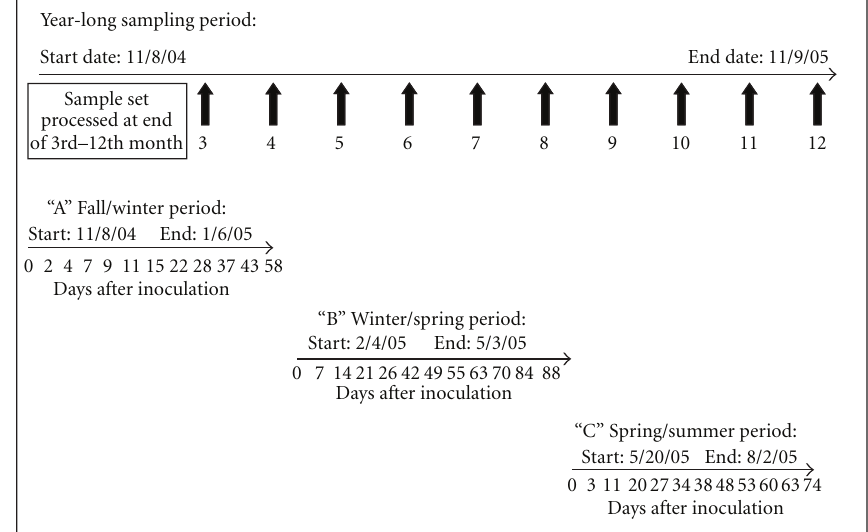
Figure 1: Timing of processing samples after M. bovis inoculation over year-long and seasonal sampling periods.